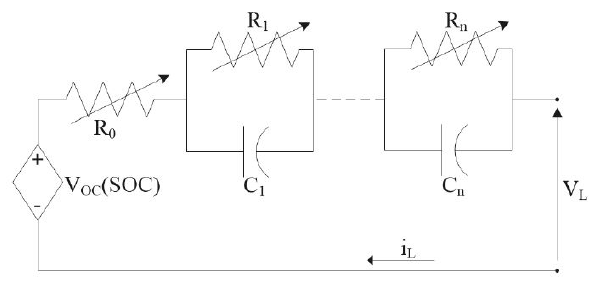
Figure 1. Equivalent electrical circuit of the battery model used in the study.